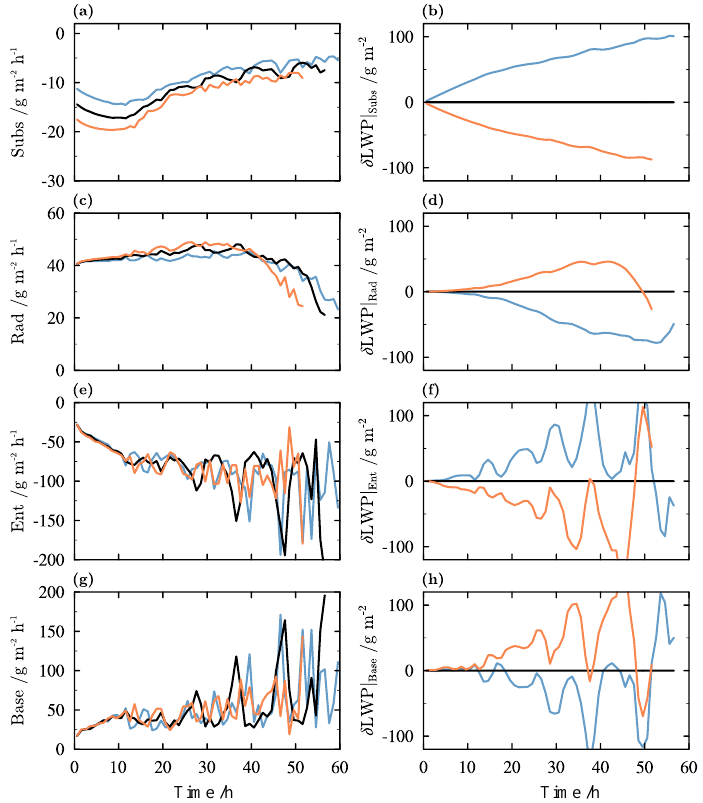
Figure 6. The LWP tendencies due to (a) subsidence, (c) radiation, (e) entrainment and (g) cloud base turbulent fluxes as a function of time for each of the sensitivity simulations. The LWP differences with the reference (black) due to each of these processes have been calculated according to Eq. (13) and are shown in panels (b) , (d) , (f) and (h) , respectively. Colors according to the legend in Fig.